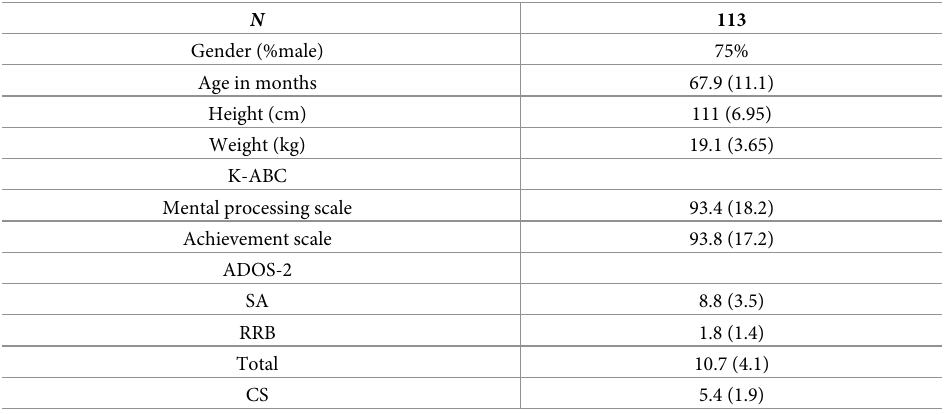
Table 1. Demographic characteristics of study